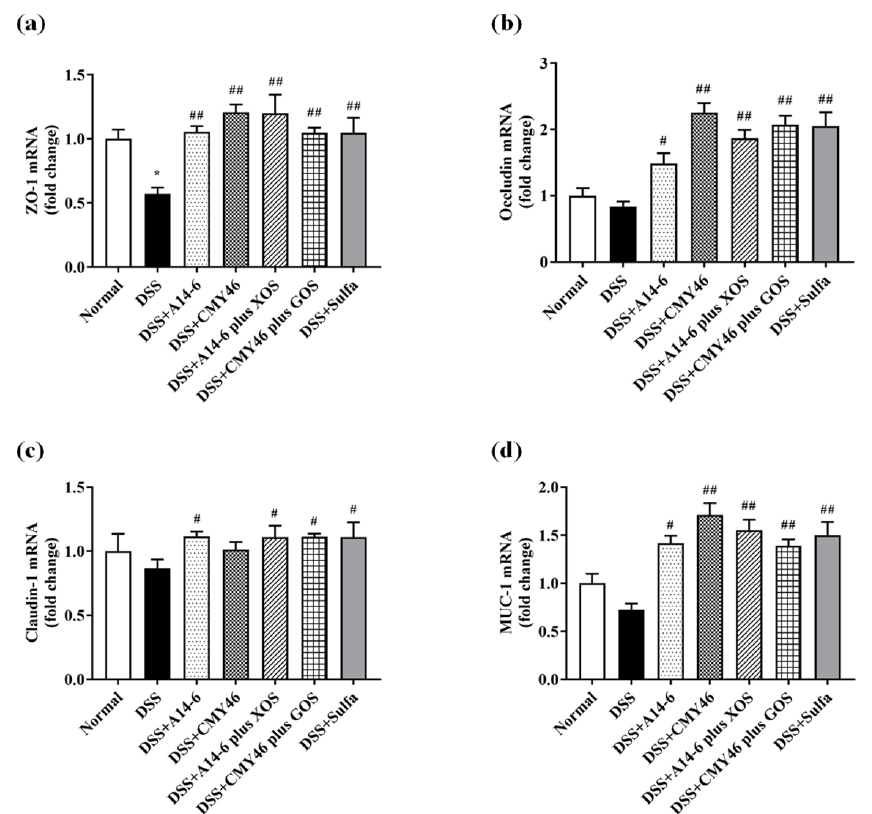
Figure 5. The effect of probiotics and synbiotics from Miang on colonic barrier integrity. ( a ) The expression of ZO-1; ( b ) occludin; ( c ) claudin-1; and ( d ) MUC-1 in the colon were detected by qRT-PCR analysis. Data are expressed as mean ± SEM ( n = 7), * p < 0.05 vs. normal group. # p < 0.05; ## p < 0.01 vs. DSS group.